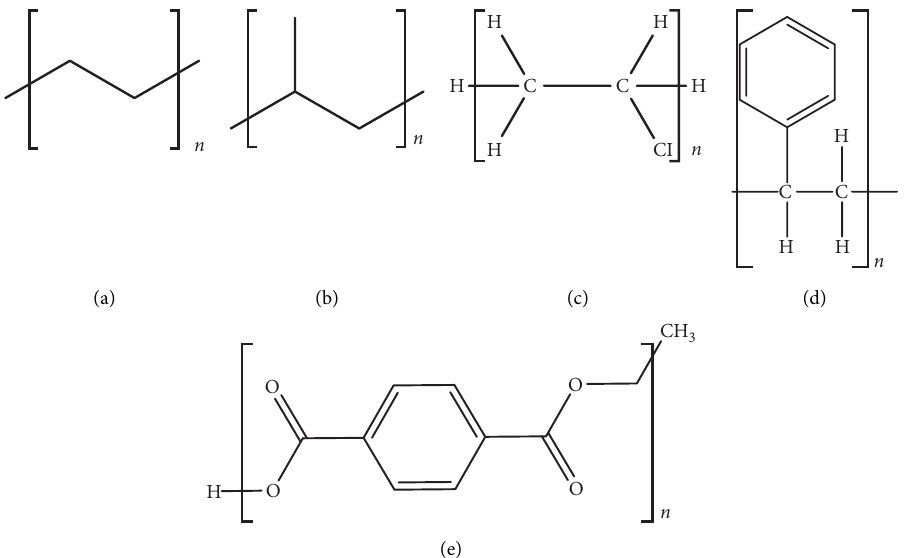
Figure 6: Chemical structure of (a) polyethylene, (b) polypropylene, (c) polyvinyl chloride, (d) polystyrene, and (e) polyethylene tere- phthalate as nonbiodegradable composite-based food